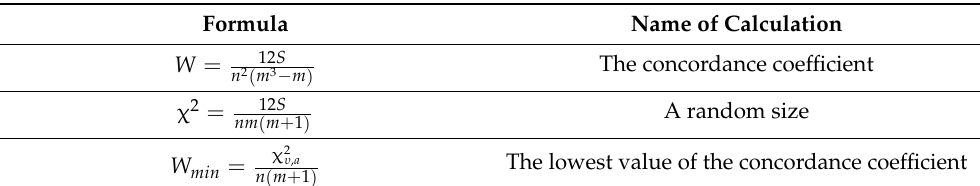
Table 5. Formulas for calculating concordance coefficients (source: compiled by authors based on) [62–64].